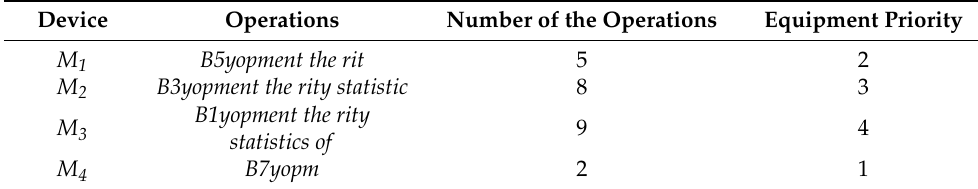
Table 1. Equipment priority statistics of complex product B.